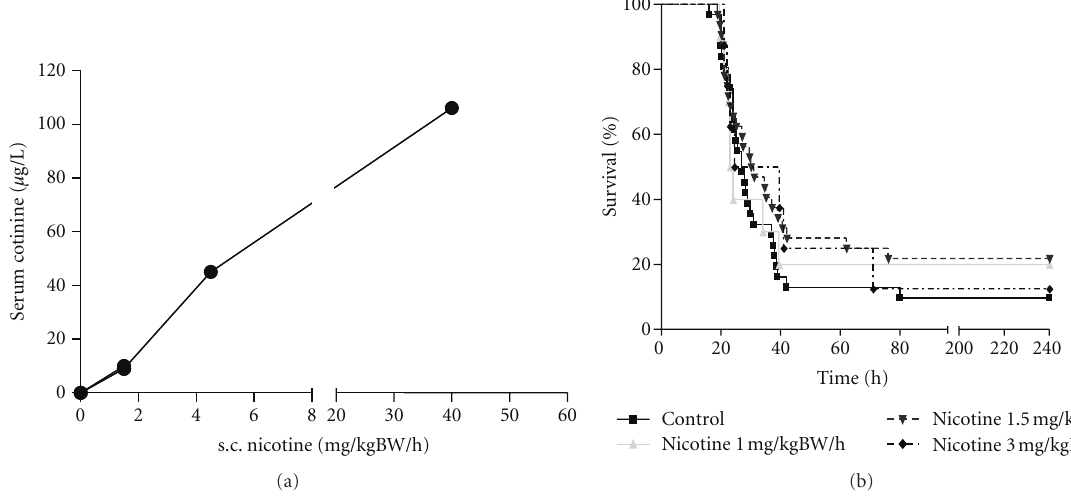
Figure 4: (a) To verify the therapeutic dose of nicotine in the murine serum, we analysed the serum cotinine level as this correlates with the amount of nicotine dose applicated by osmotic pumps. Application of nicotine in a dose of 1.5mg/kgBW/h results in a serum cotinine level of 9.24 μ g/l ( n = 4). 4.5 mg/kgBW/h nicotine leads to a cotinine serum concentration of 45 μ g/l ( n = 1) and 40mg/kgBW/h nicotine induces a cotinine serum concentration of 106 μ g/l ( n = 1). Serum samples were analysed 18 hours following CASP. (b) The survival in CASP is not altered by continuous nicotine administration through subcutaneously implanted osmotic pumps. A nicotine exposition of 1 mg/kg bw per hour correlates with a survival rate of 20% ( n = 10), 1.5 mg/kgBW/h ( n = 32) nicotine leads to a survival rate of 21.85% and 3mg/kgBW/h nicotine correlates with a survival rate of 12,5% ( n = 8). In the control group, NaCl was applied where the survival rate was detected with 9.76% ( n = 31).